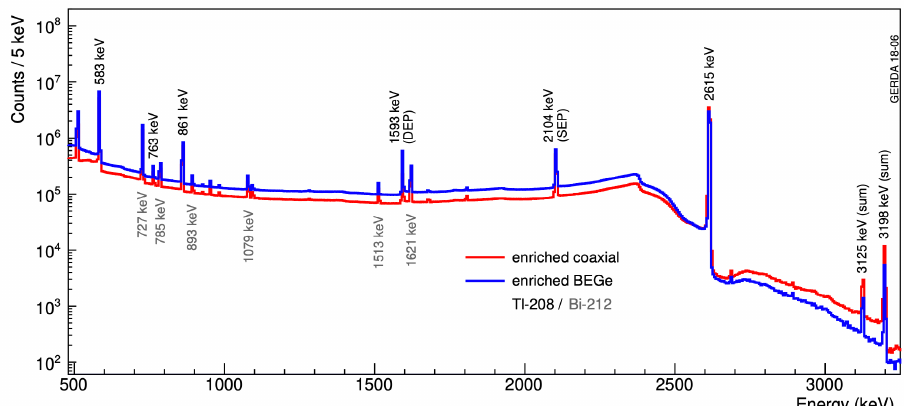
Figure 18. Combined energy spectrum for 228 Th calibration data for all enriched detectors of BEGe (in blue) and coaxial (in red) during Phase II.